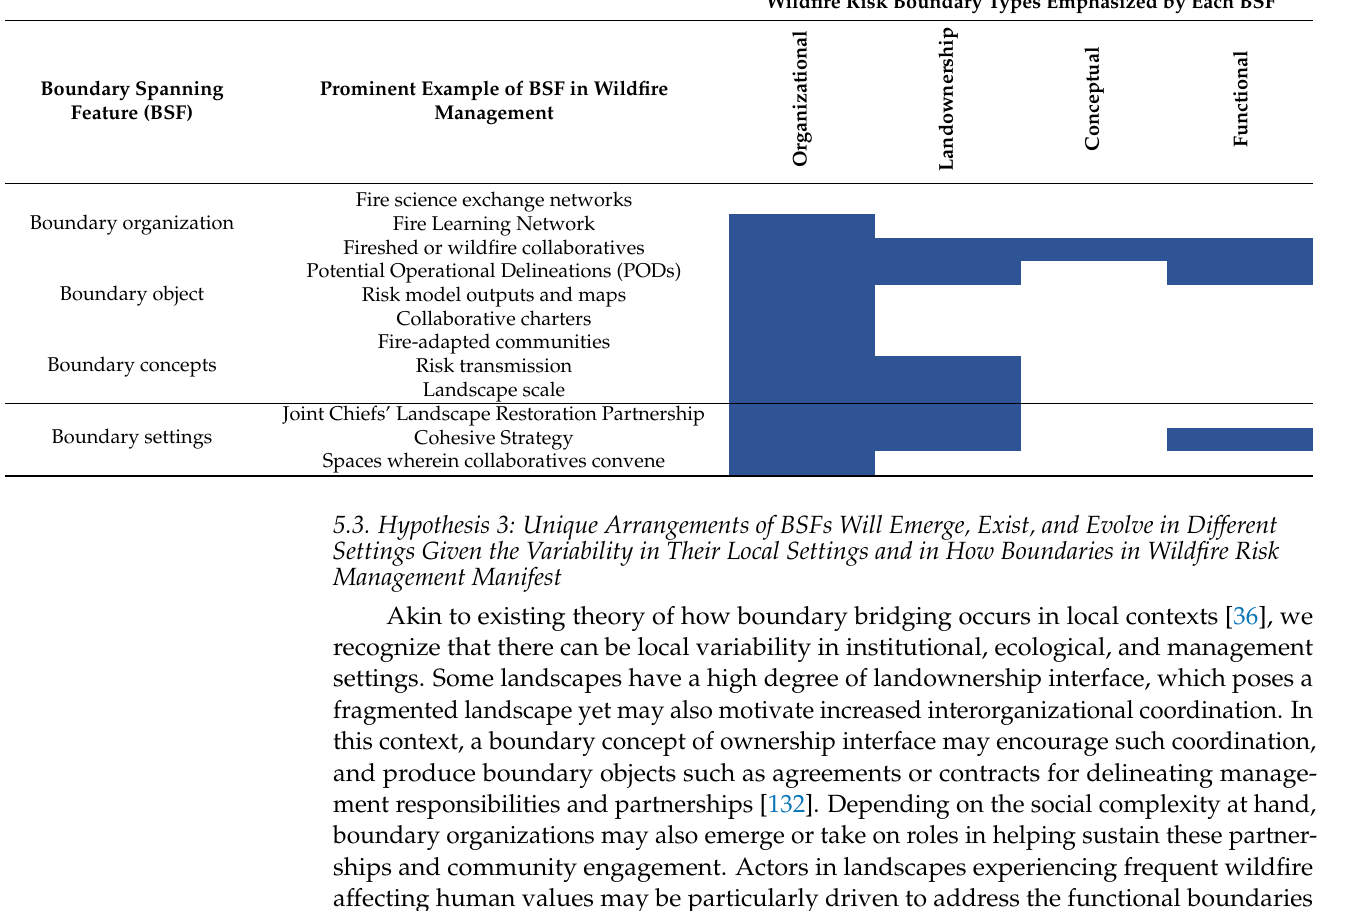
Table 3. Potential examples of boundary spanning features and the boundaries that they emphasize in wildfire management Wildfire Risk Boundary Types Emphasized by Each